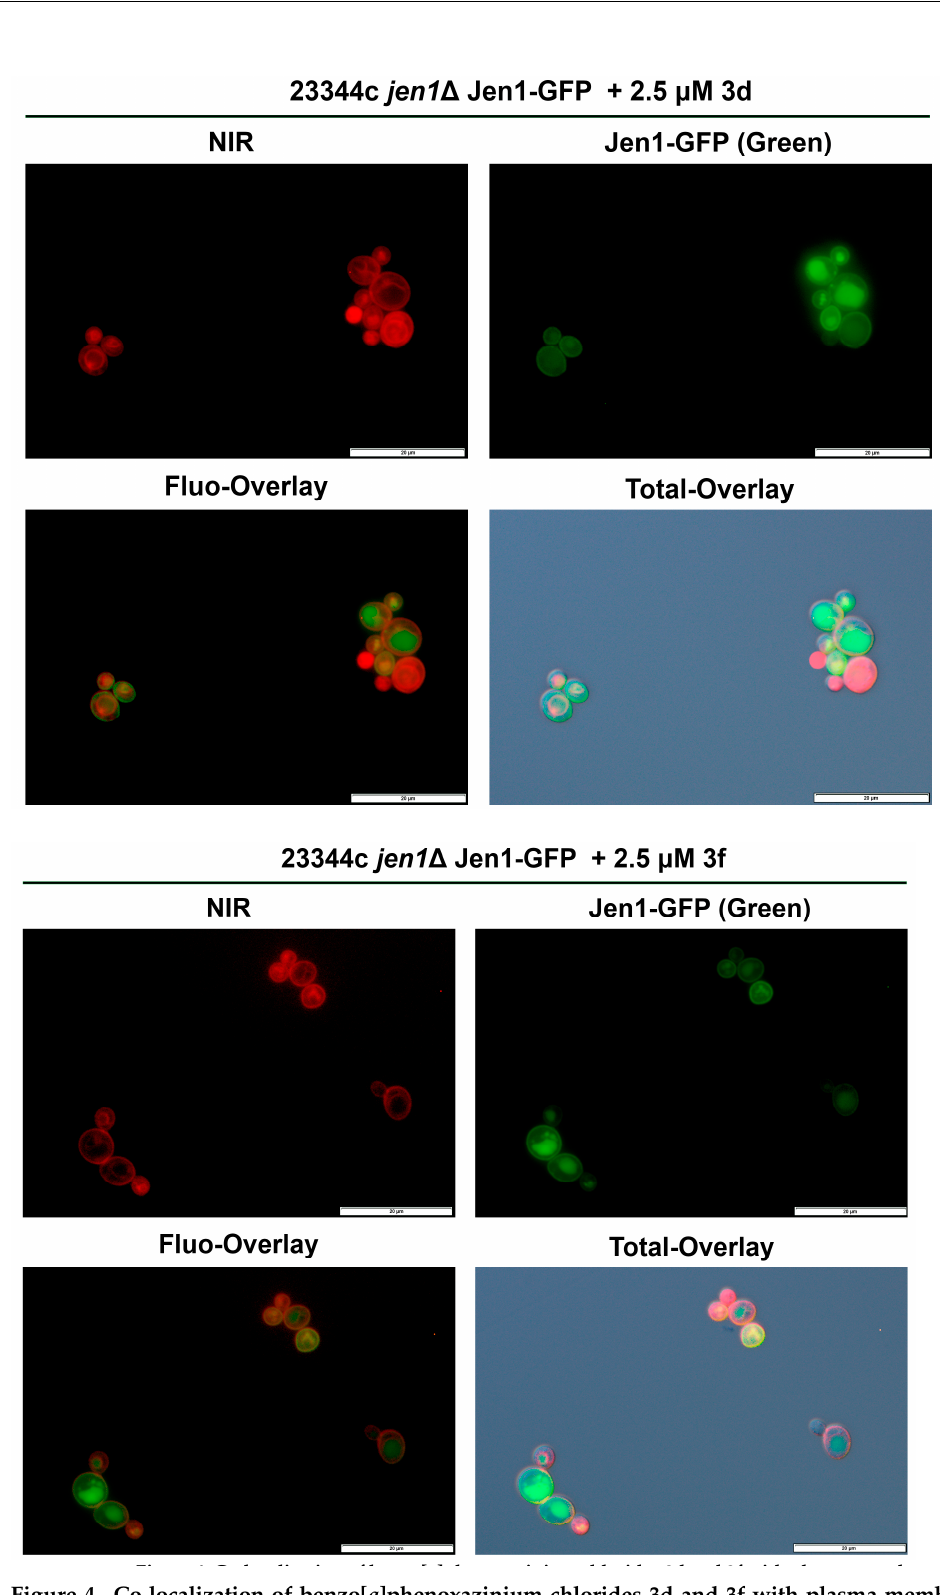
Figure 3. Co-localization of benzo[ a ]phenoxazinium chlorides 3a–f with perinuclear membrane of the endoplasmic reticulum. Fluorescence microscopy images of BY4741 Sec66-GFP cells after incubation with 3a–f (2.5 µM) for 1 h. Samples were rinsed two times in PBS 1× and mounted on a slide for observation with a 60× oil immersion objective, using the adequate filters U-FDICT, ET- CY5-FAR-RED (exciter filter: 595–645 nm/emission filter: 665–715 nm), and TLV-U-FF-FITC (exciter filter: 455–495 nm/emission filter: 505–555 nm). Representative images of three independent exper- iments. Scale bar 20 µm.